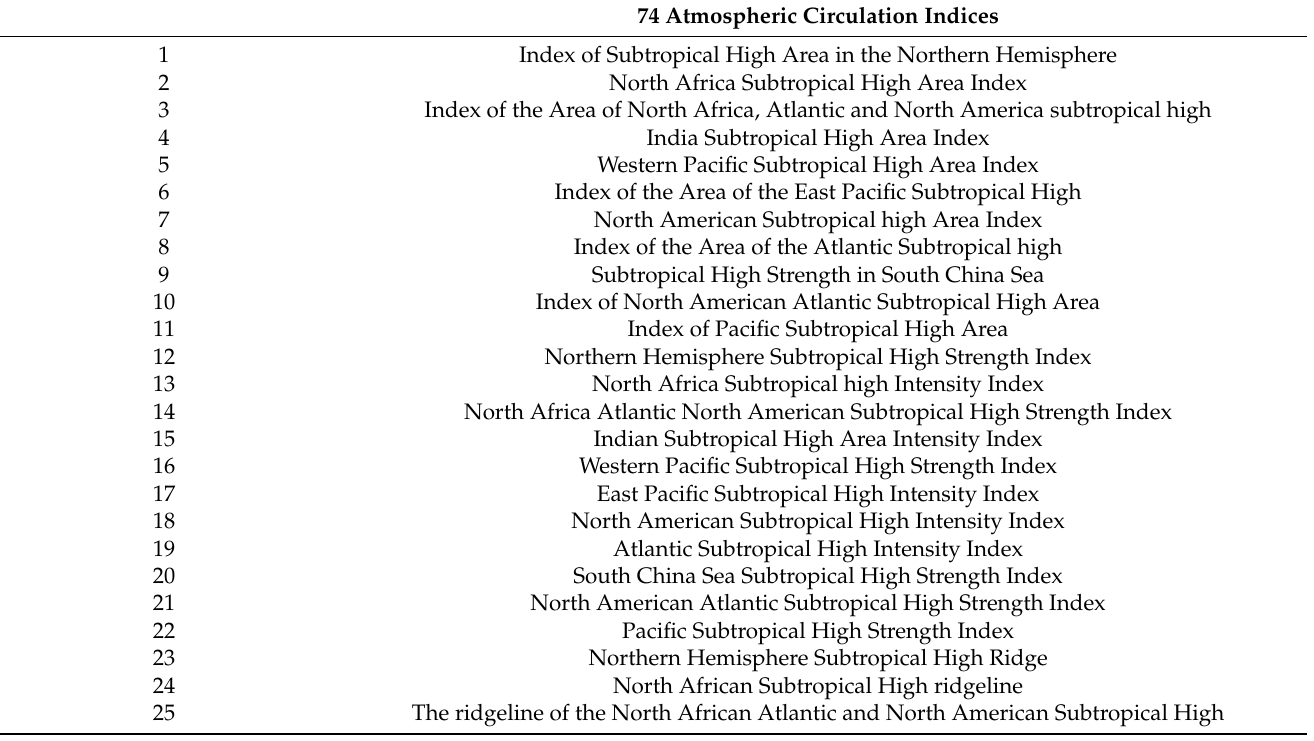
Table A1. The data source from the Climate System Diagnosis and Prediction Office of the National Climate Center (ncc-cma.net, accessed on 15 May